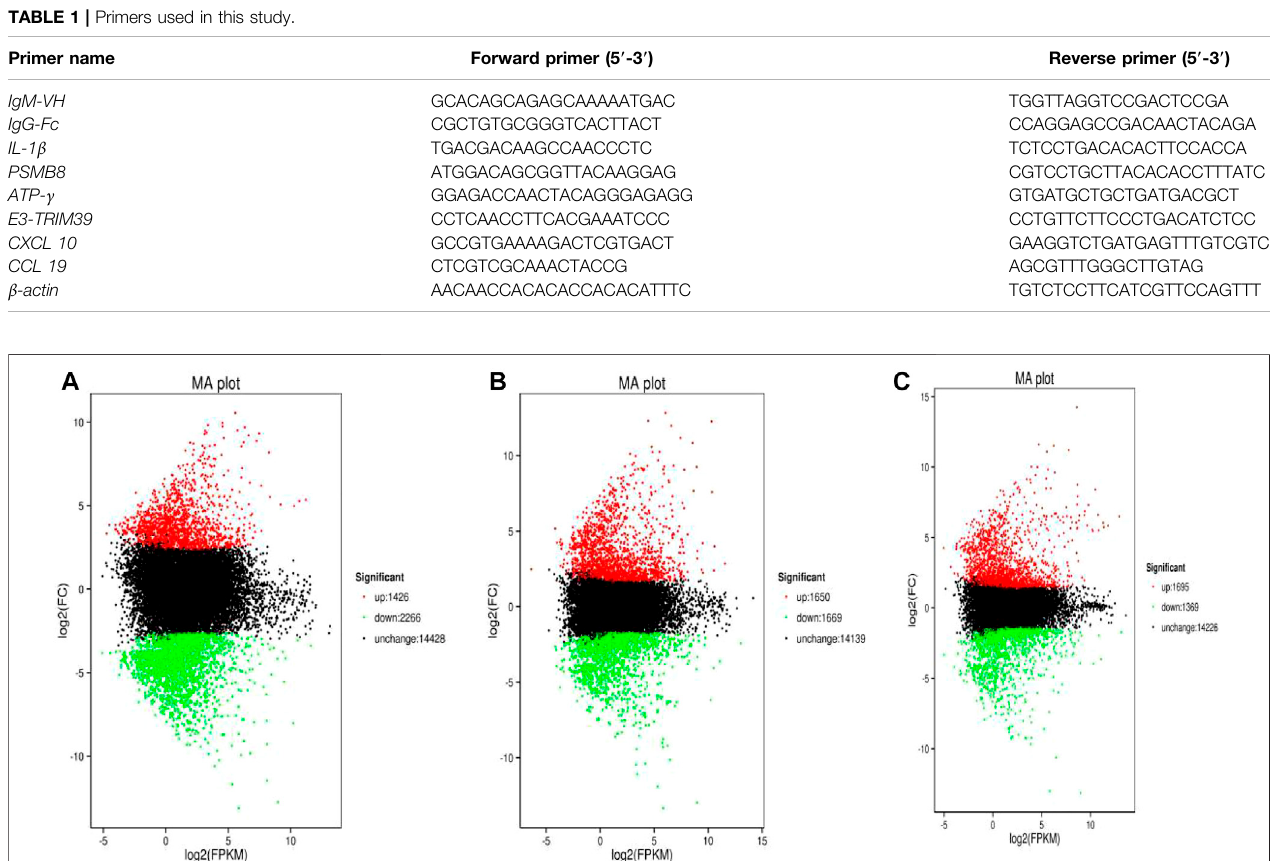
FIGURE1| VolcanoplotofNiletilapiaDEGsidenti fi edfromthe Streptococcus challenge.AGgroup24 hvscontrolwasshownin (A) ,IGgroup24 hvscontrolwasshownin (B) ,whileMGgroup24 hvscontrolwasdisplayedin (C) .Thelog2(FPKM)valuerepresentedthemeanexpressionlevelofeachgene,andeachdotrepresentedonegene.Theup- regulated genes were shown in red dots, the down-regulated genes were shown in green dots, while genes with no differential expression were shown in black dots.